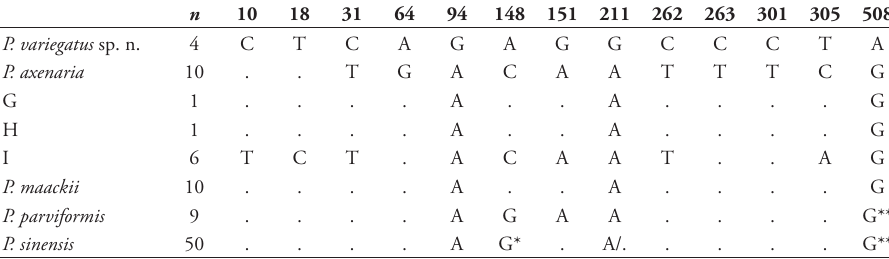
Table 3. Selection of diagnostic sites of the mtDNA fragment comprising the partial ND4 gene and ad- jacent DNA coding for tRNAs for Pelodiscus species (91 wild-caught individuals from Gong et al. 2018). Positions refer to the 838-bp-long reference alignment in the Supporting Information. G, H, and I are genetic lineages that represent putatively distinct taxa (Gong et al.